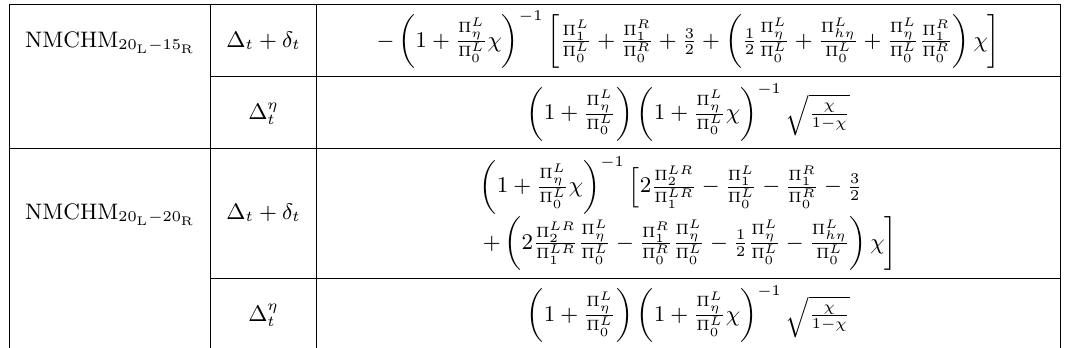
Table 6. Expressions for ((cid:1) t + (cid:14) t ) and (cid:1) (cid:17) quark is